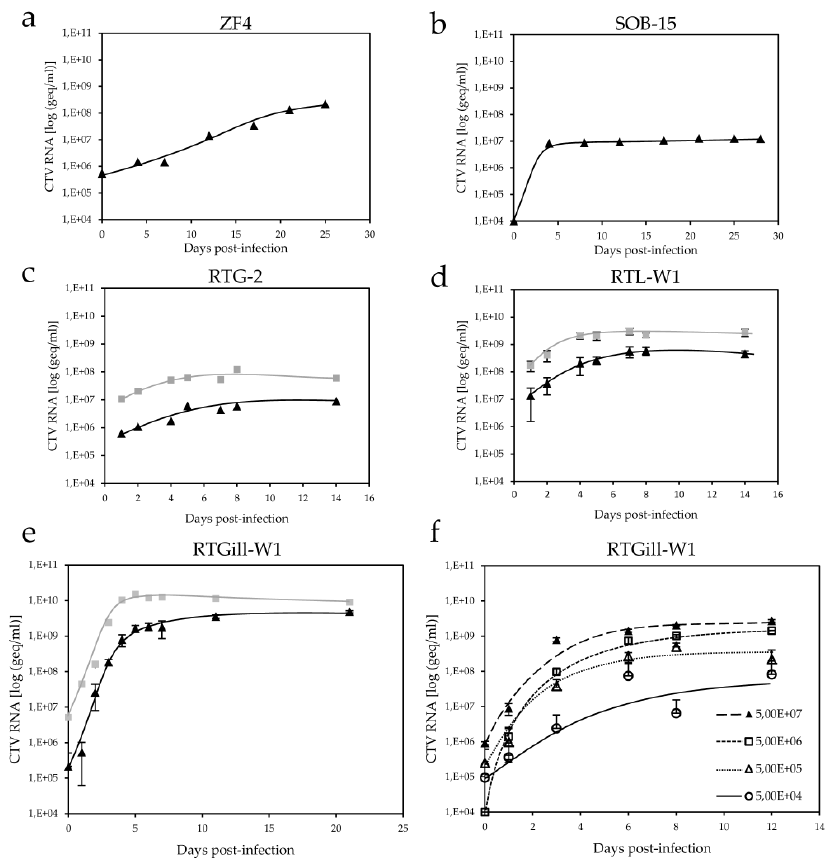
Figure 1. Quantitative analysis of cutthroat trout virus (CTV) RNA in cell culture supernatant (SN) ( ) and cellular fractions ( ) by reverse transcription ‐ polymerase chain reaction (RT ‐ PCR). ( a ) ZF4; ( b ) SOB ‐ 15; ( c ) RTG ‐ 2; ( d ) duplicate samples of RTL ‐ W1; and ( e ) triplicate samples of RTGill ‐ W1 cells; ( f ) Comparison of viral RNA in duplicates in cell culture SN using 10 ‐ fold dilutions of input CTV, as indicated.